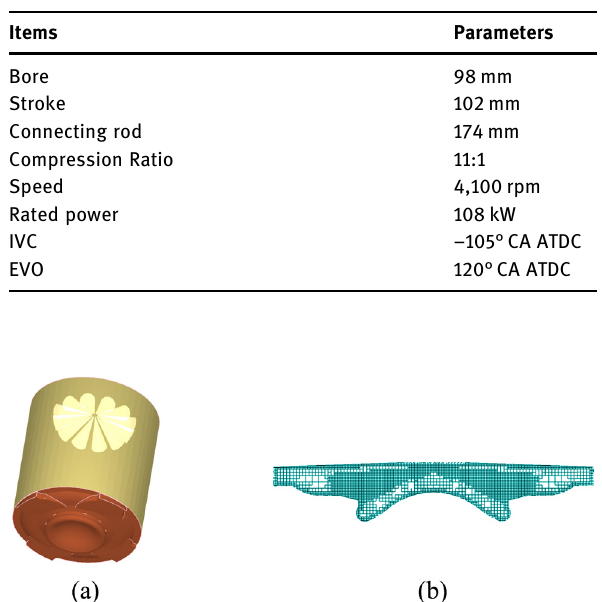
Table 2: Speci fi cations of the diesel engine